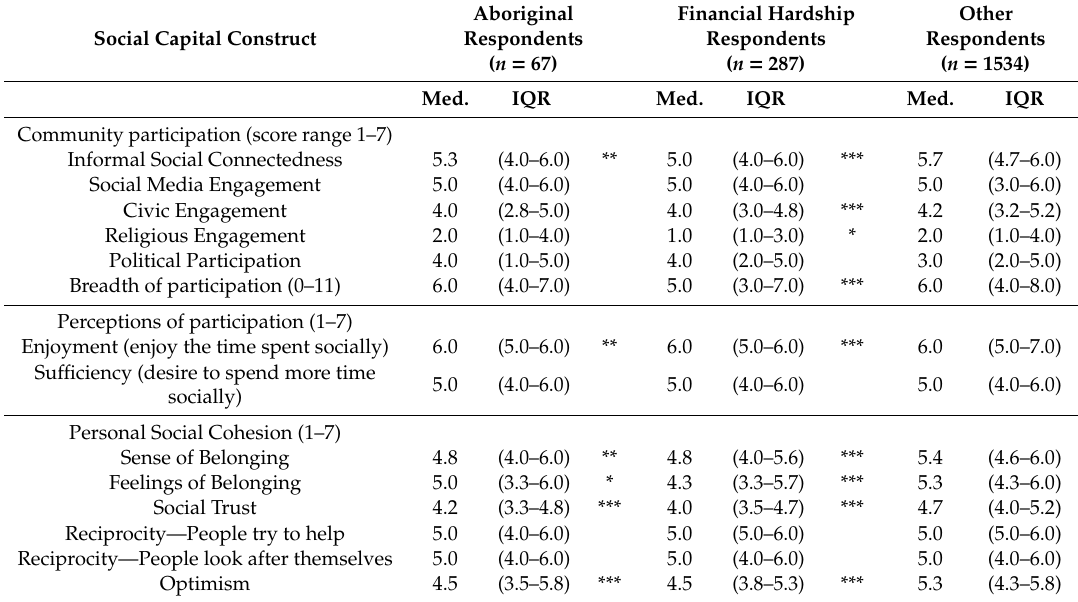
Table 4. Medians and interquartile ranges (IQR) for social capital variables in three respondent groups (higher scores indicate greater agreement with perception statements; n =